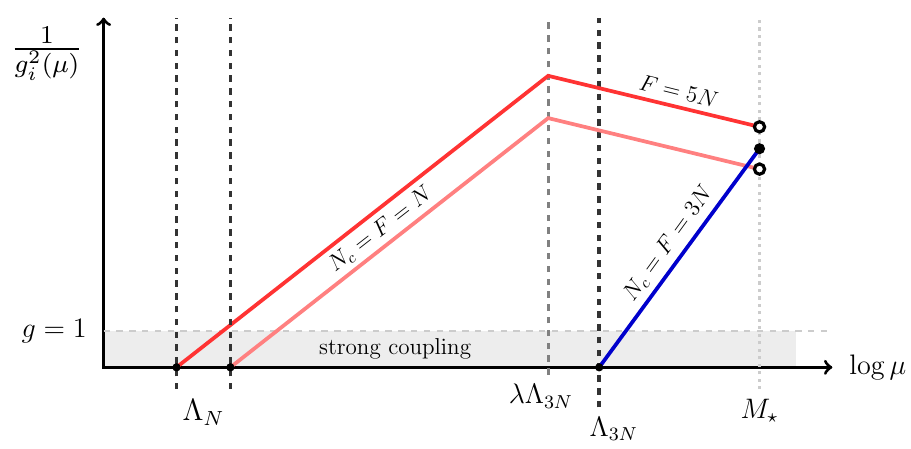
Figure 4 . An illustration (not exactly to scale) of the running couplings for one N c = 3 N and two N c = N gauge groups, taken to have similar values near µ ∼ M ? . The narrative in this section follows the plot from right to left, UV to IR. Between M ? and Λ 3 N , g 3 N (in blue) runs quickly towards strong coupling, with the slope on the plot given by b = 3 N c − F = 6 N , while the g N